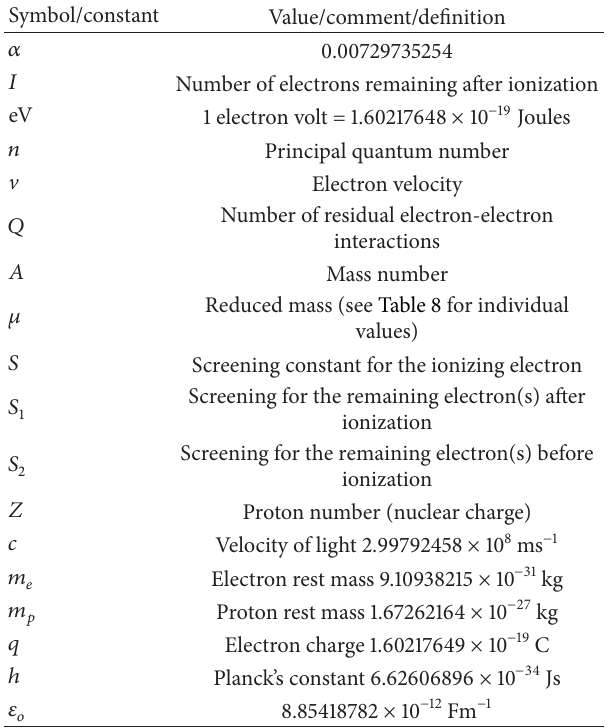
Table 1: Symbols, conversion factors, and constants (to 9 significant